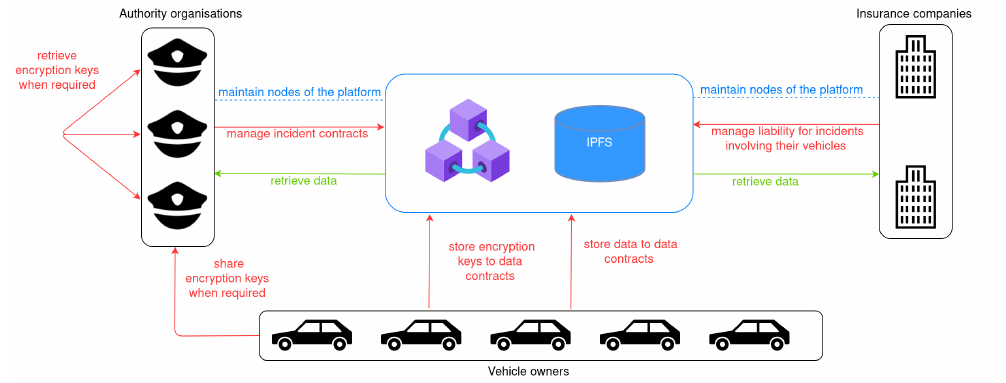
Figure 1. Actors and interactions with